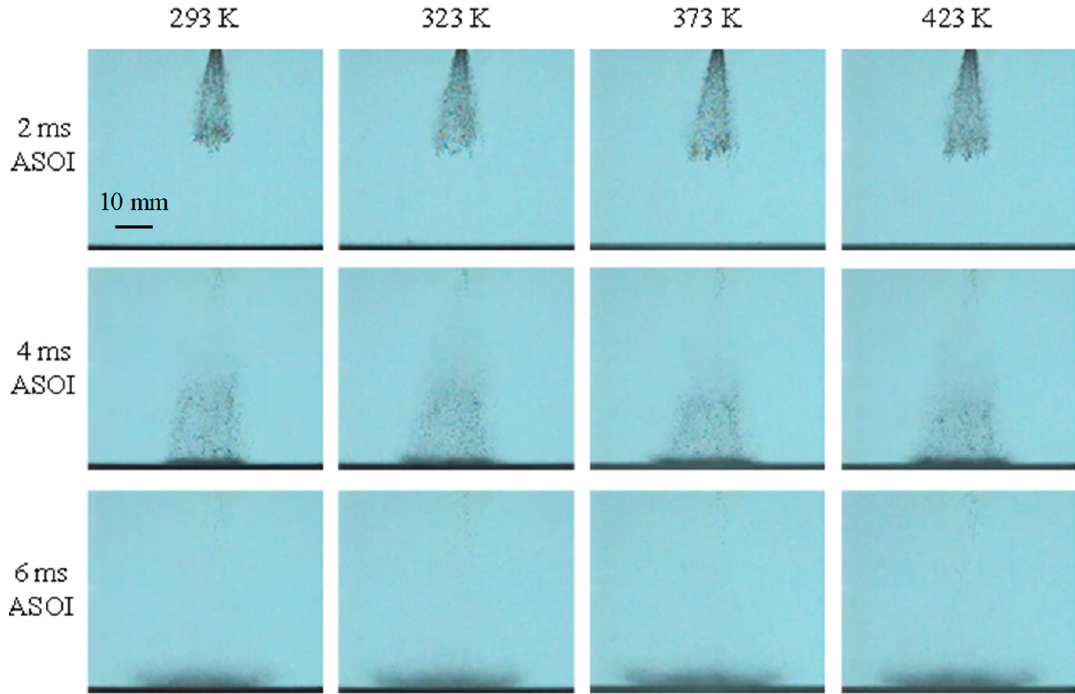
T . Figure 8. The spray morphology under different T Figure 8. The spray morphology under different wall . wall Figure 9 showed the changes in H i and W i with time. When T wall was 323 K, 373 K, and 423 K, H i was significantly higher than that of the usual temperature wall before 5 ms ASOI. However, in the following time, the changes of H i corresponding to different T wall were similar. Generally, H i of methanol spray on the wall was positively correlated with T wall . Similarly, W i was positively correlated with T wall . However, the relative difference between W i curves of T wall 373 K and 423 K in a short time after the spray impacted